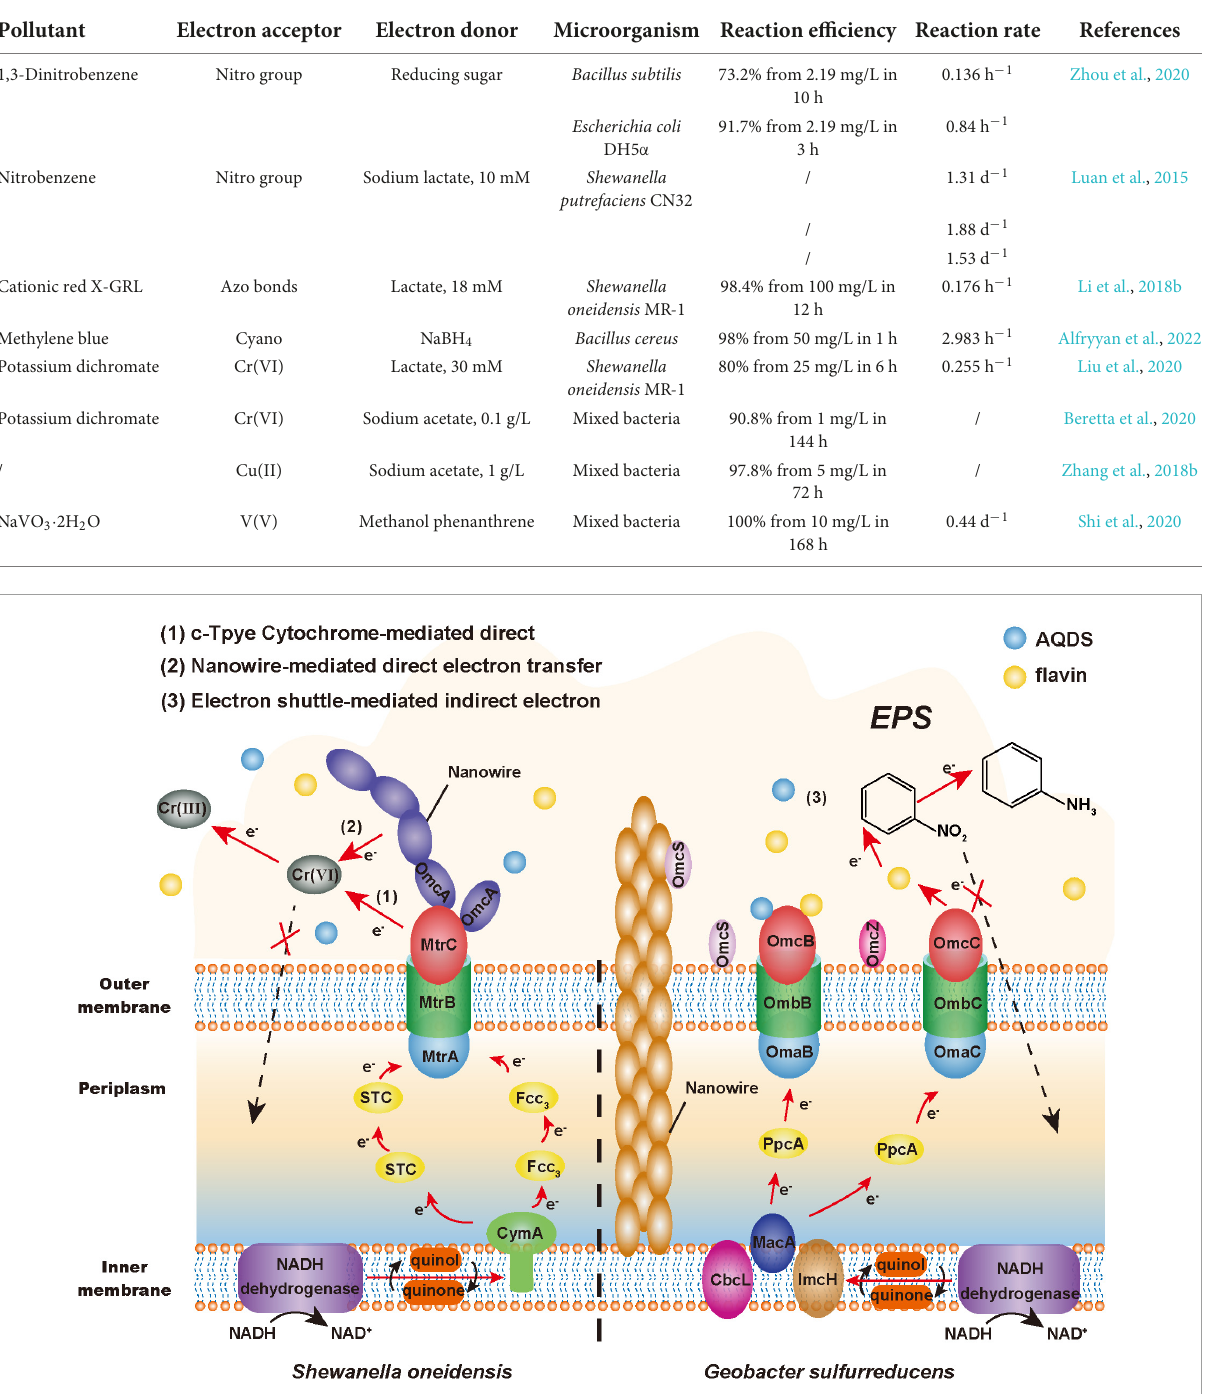
FIGURE2 Extracellular detoxification mechanism of electroactive microorganisms (EAMs). The red arrow represents the electron transfer pathway, the black arrow represents the material transformation process, and the dashed arrow represents the non-occurring toxicity effects.